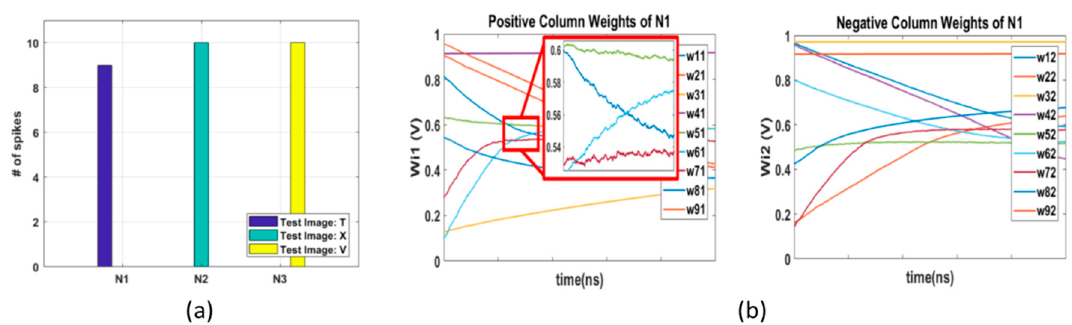
Figure 5. ( a ) 3 × 3 T, X, and V letter image classification test results. Nine different T images were responded to by N1, 10 different X images were responded to by N2, and 10 different V images were responded to by N3. The test results show that the memristor ANN was successfully trained as the predefined learning pattern; ( b ) synaptic weight changes of output neuron 1 during 50 sets of guide